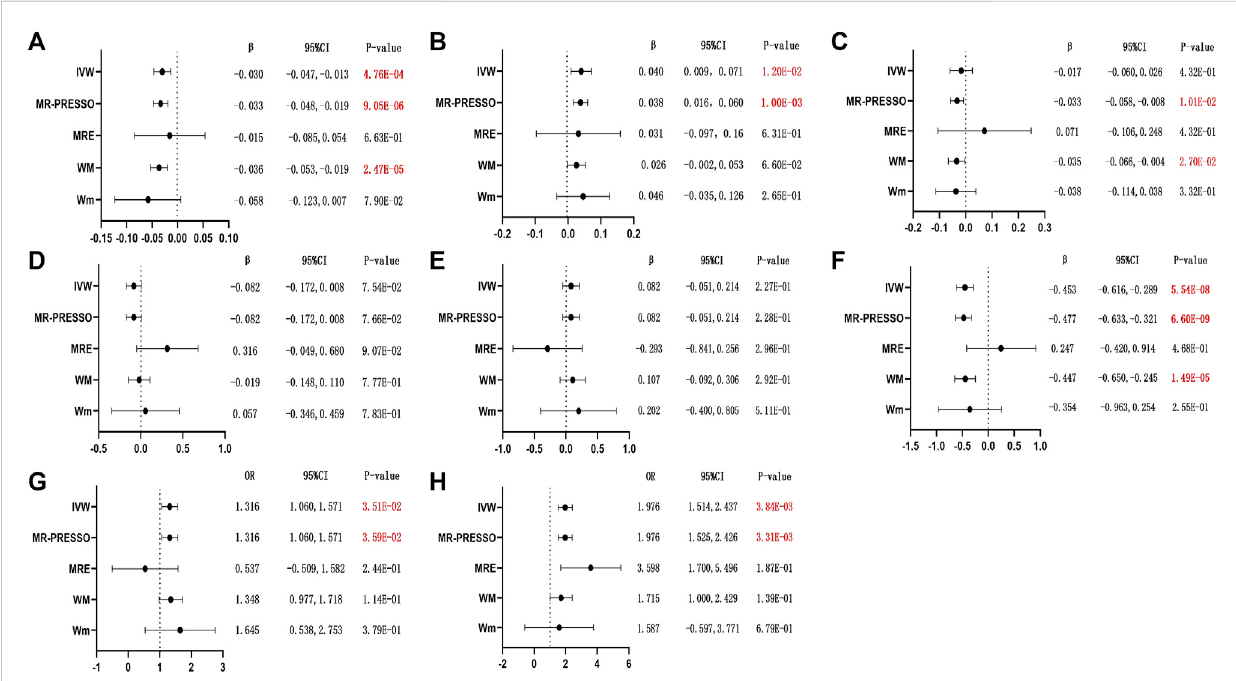
FIGURE 1 MR results of causal effects of smoking initiation SNPs on related outcome risks. (The estimates were derived from the random-effects inverse- varianceweighted(IVW)model,theMRpleiotropyresidualsumandoutlier(MR-PRESSO)approach,MR-Egger(MRE)regression,weightedmedian(WM), and weighted mode (Wm). (A – H) : (A) sex hormone-binding globulin, SHBG; (B) bioavailable testosterone, bio-T; (C) total testosterone, TT; (D) estradiol, E 2 ; (E) anti-Mullerianhormone,AMH; (F) ageatmenopause; (G) irregularmenstrualcycle/bleeding;and (H) dysmenorrhea. OutliersofMR-PRESSO: (A) rs56208390, rs3115418, rs13066050, rs7631379, rs3934797, rs1116690, rs7743165, rs9331343, rs76841737, rs11192347, rs644740, rs76460663, rs1106363, rs11611651, rs62052916, rs4476253, and rs7505855; (B) rs56208390, rs3115418, rs13066050, rs1549979, rs1116690, rs2173019, rs7024924, rs10969352, rs11192347, rs76460663, rs62052916, and rs4476253; (C) rs1518393, rs3115418, rs13066050, rs1549979, rs2173019, rs359431, rs13261666, rs7024924, rs10966092, rs10969352, rs11192347,and rs76460663; (D) N; (E) N; (F) rs160631, rs9331343, rs10966092, andrs56902655; (G) N;and (H) N. p -values < 5.00E-02 are presented in red, and red and bold font means p -values < 2.08E-03. β , beta; CI, con fi dence interval; OR, odds ratio; N,